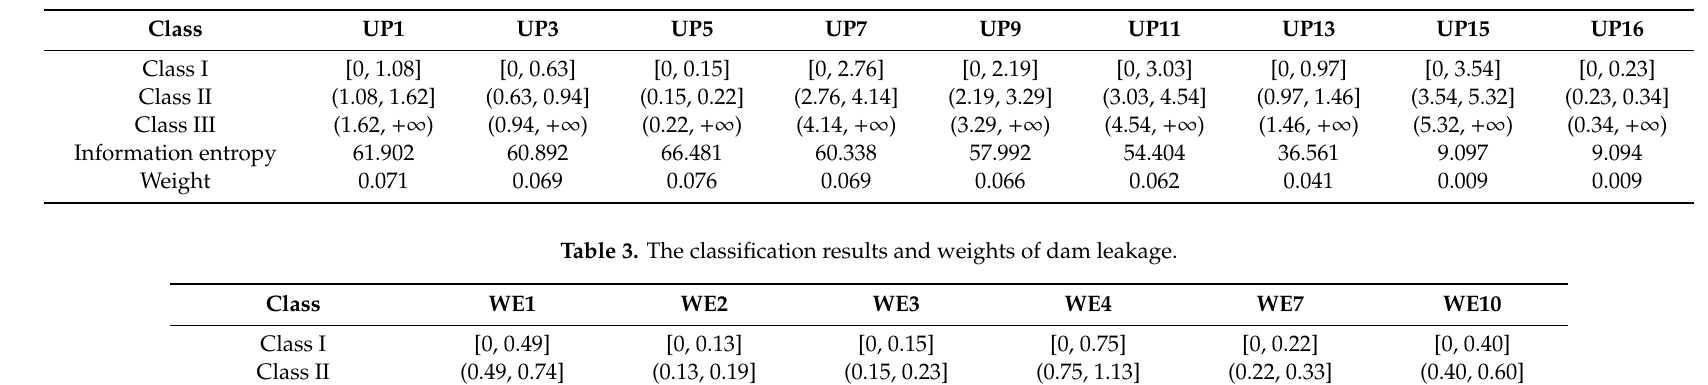
Table 2. The classification results and weights of dam seepage pressure.